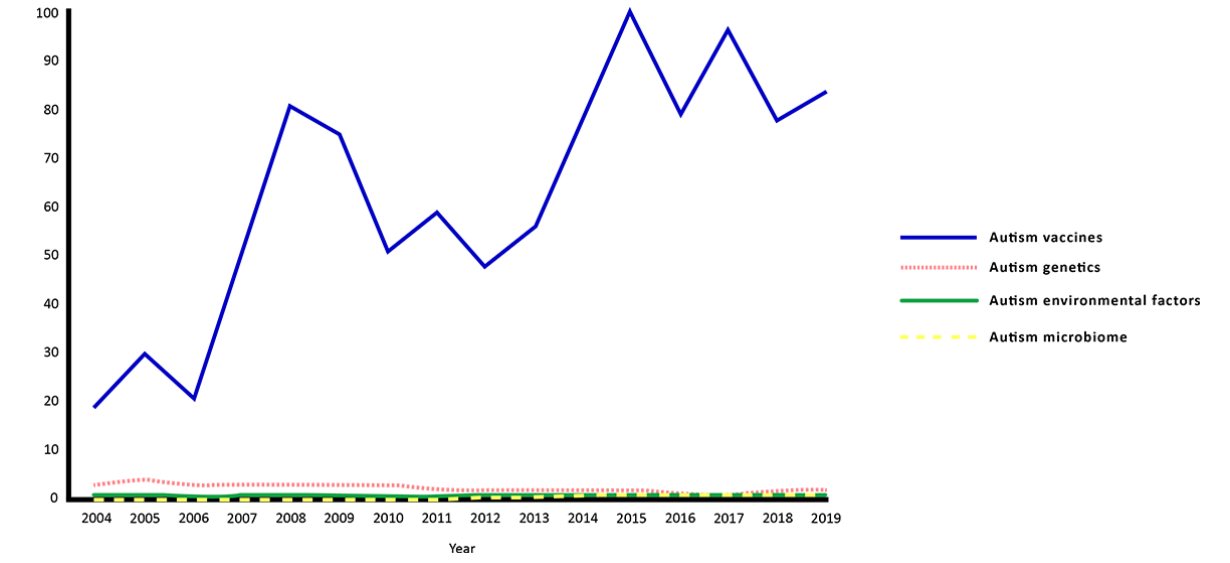
Figure 1. Google Trends analyses for web searches related to queries about the causes of autism in the United States from 2004 to